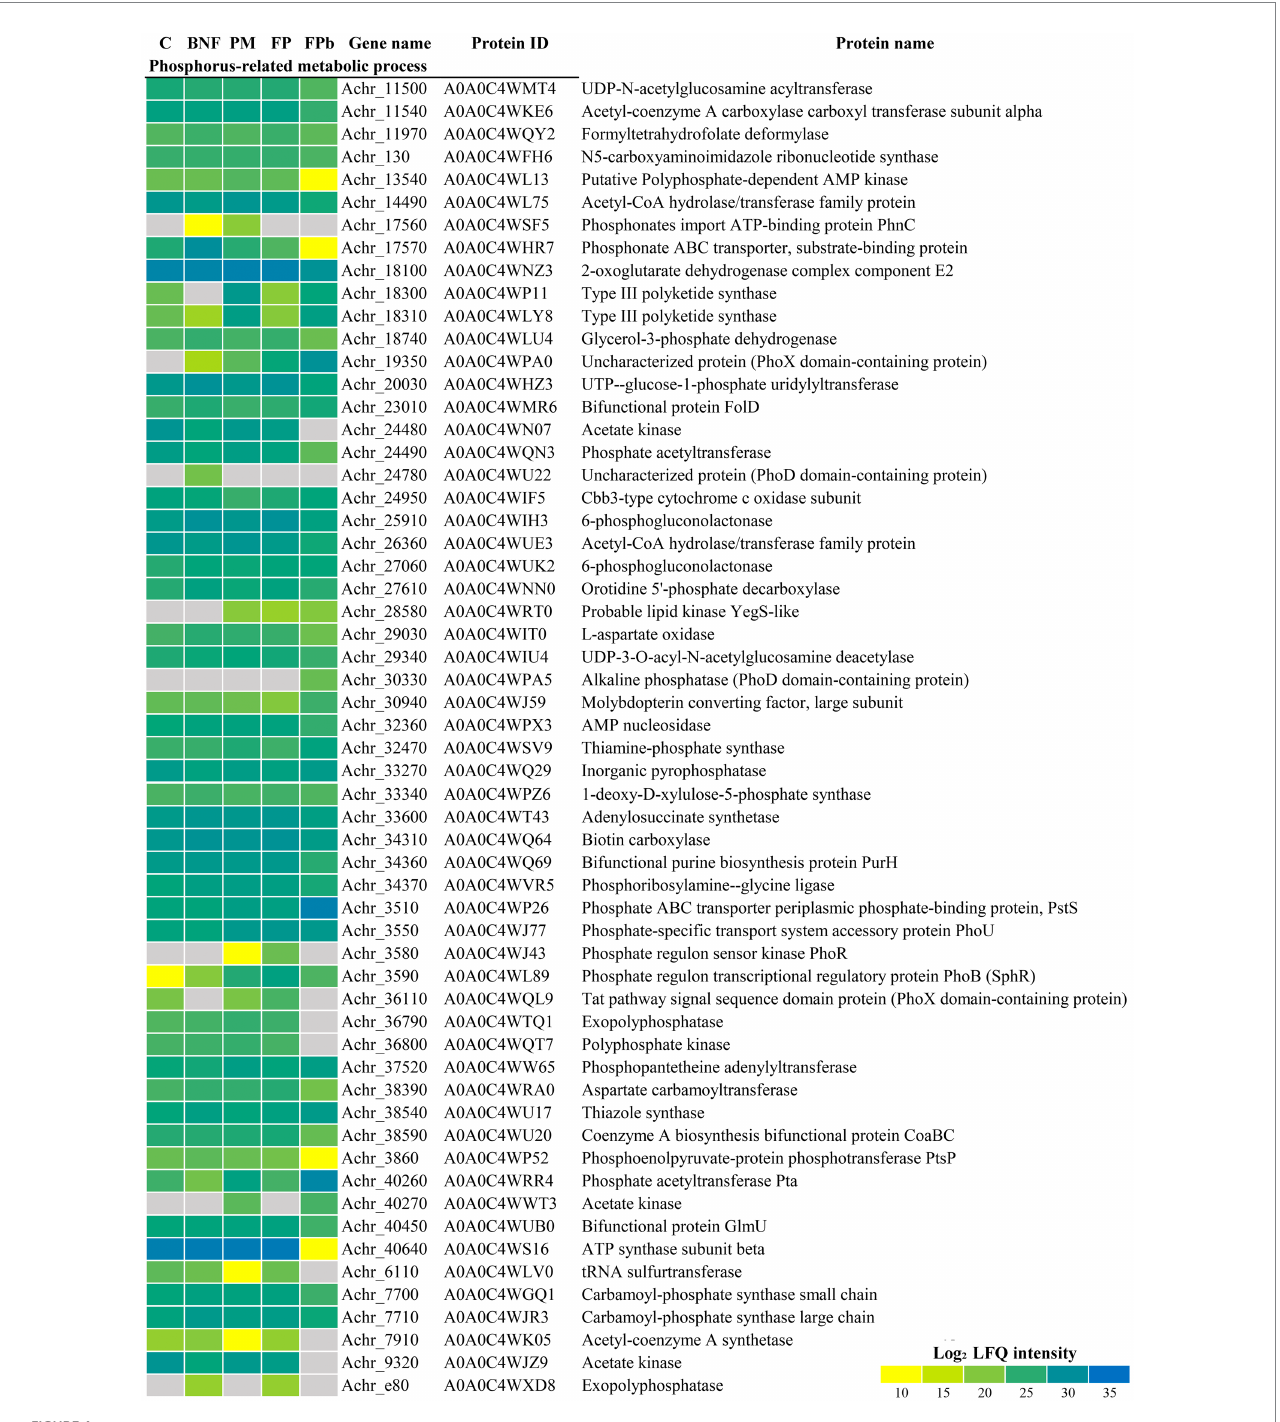
FIGURE 4 Differential expression of proteins related to phosphorus metabolism. Data are shown as heatmap of Log 2 normalized peptide intensity. C, control condition; BNF, biological nitrogen fixation condition; PM, phosphorus mobilization condition; FP, biological nitrogen condition and phosphorous condition (21 h); FPb, biological nitrogen condition and phosphorous condition (72